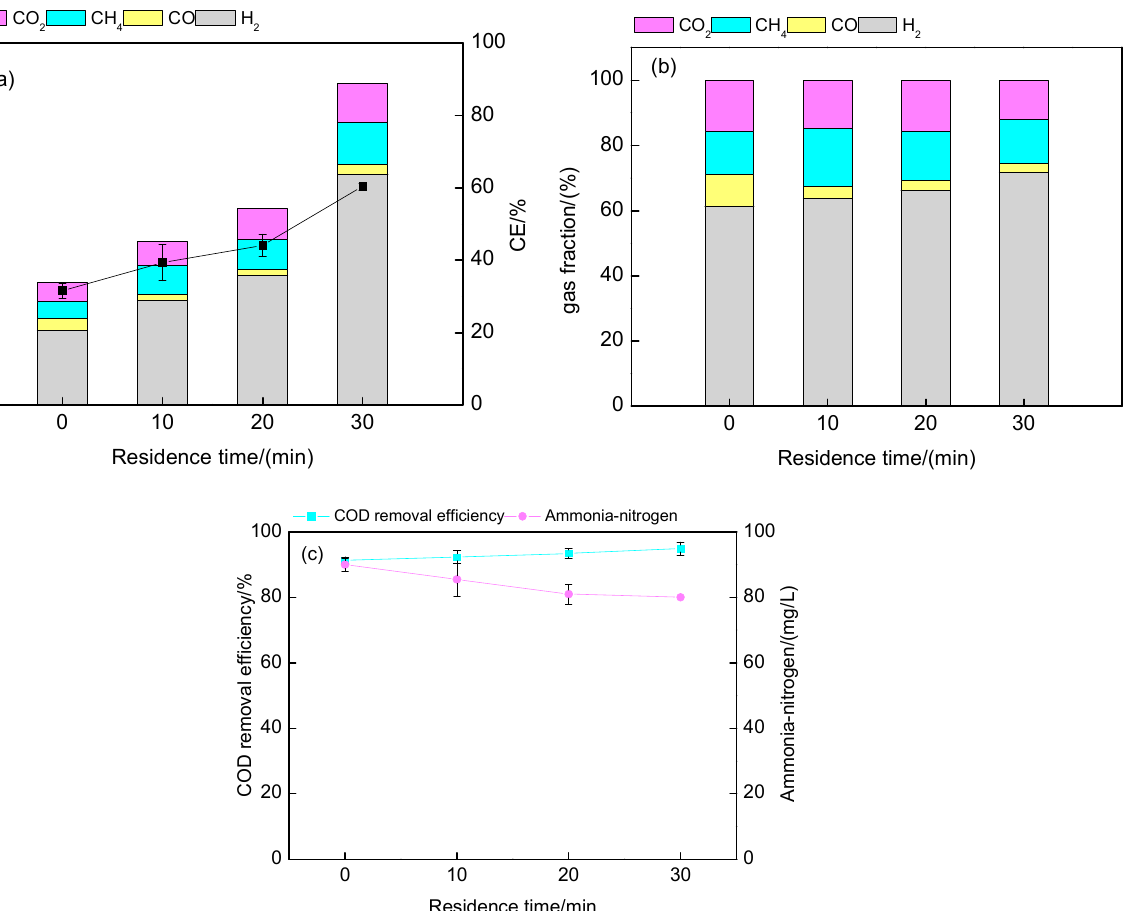
Figure 3. Effect of residence time on gasification characteristic: ( a ) gas yield and CE ( b ) gas fraction ( c ) COD removal efficiency and ammonia nitrogen (650 °C, 23 MPa).